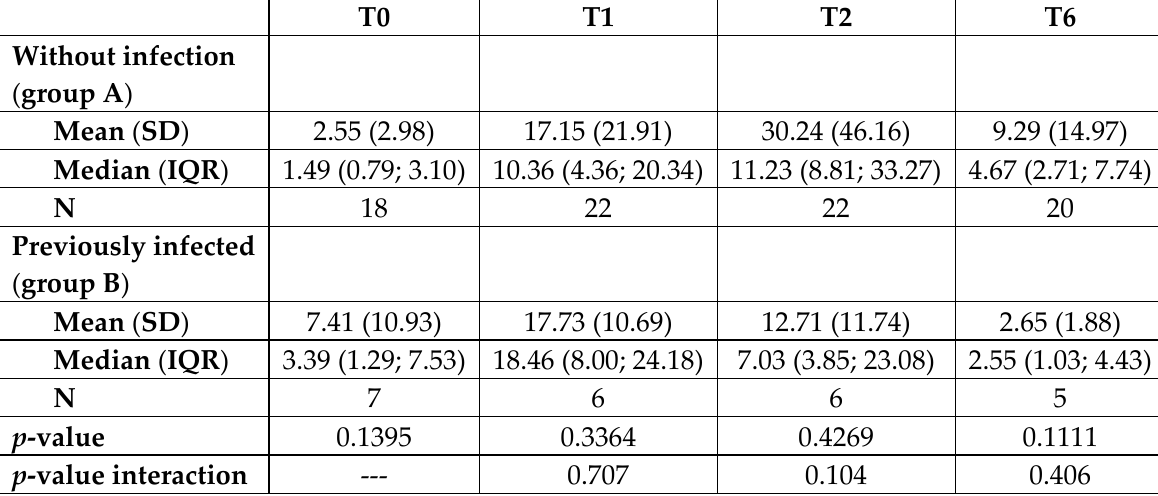
Figure 2. The CD4+ T cell response to Spike peptide megapools (MPS) in the two groups of subjects. The data are expressed as Stimulation Index (SI), mean (standard deviation, SD) and median (interquartile range, IQR). p -value between the two groups is analyzed at each timepoints with Mann–Whitney test.